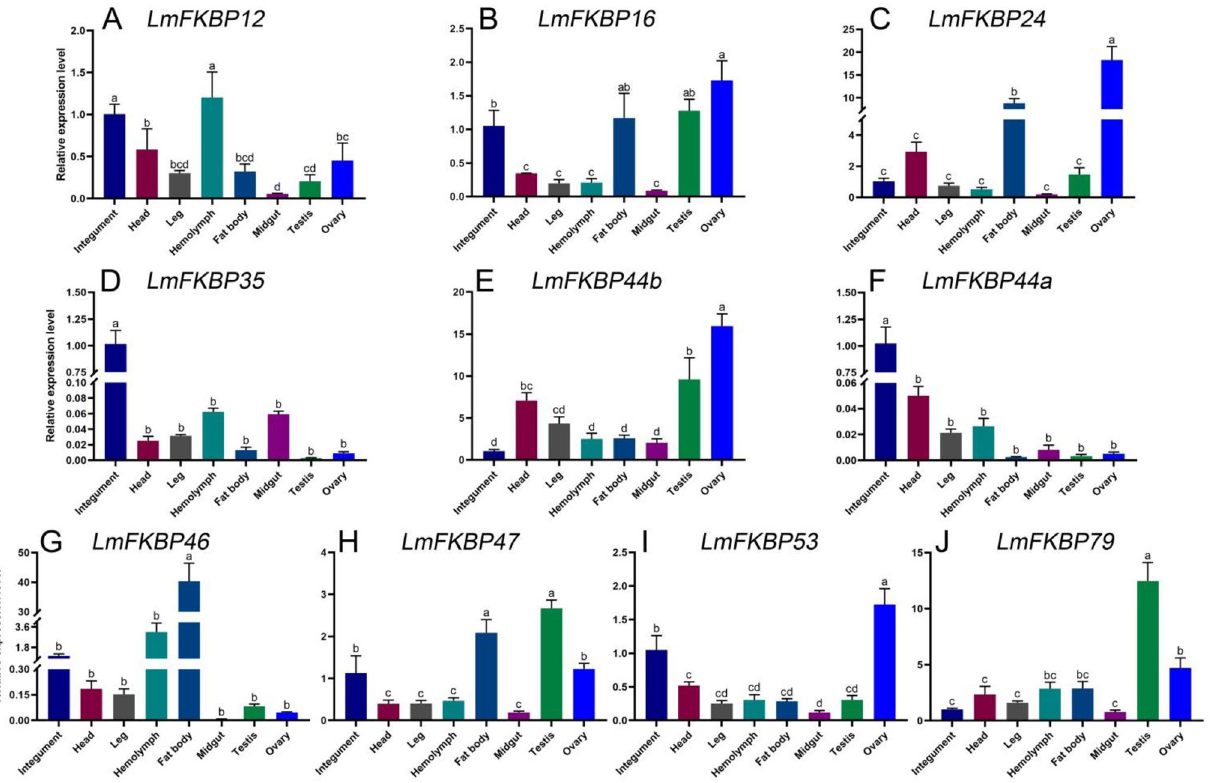
Figure 5. Expression patterns of 10 FKBPs in different tissues of L. migratoria . Bars represent Mean ± SEM (standard error of mean) (n = 3). The genes expressions in the integument were taken as the control. Different lowercase letters indicate significant differences in the relative expression levels ( P < 0.05). The X axes in ( A – J ) show the analyzed tissues of L. migratoria , including integument, head, leg, hemolymph, fat body midgut, testis, ovary. ( A – J ) are the relative expression levels of LmFKBP12 , LmFKBP16 , LmFKBP24 , LmFKBP35 , LmFKBP44b , LmFKBP44a , LmFKBP46 , LmFKBP47 , LmFKBP53 , LmFKBP79 in different